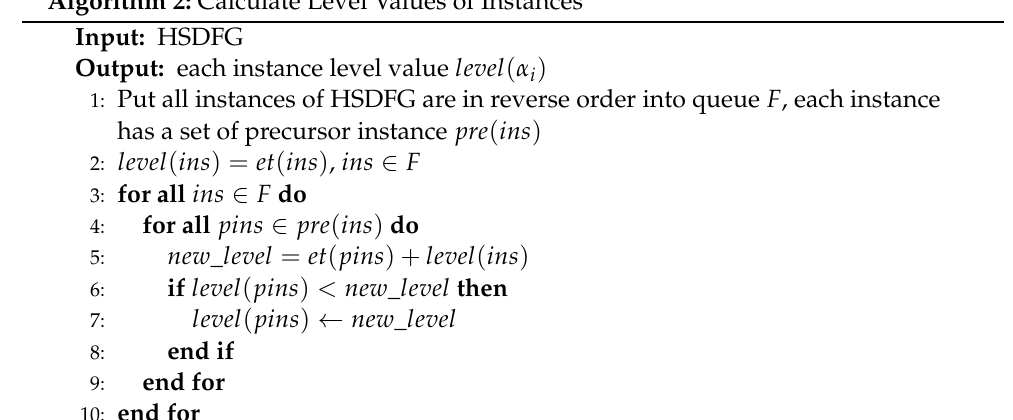
Algorithm 2: Calculate Level Values of Instances